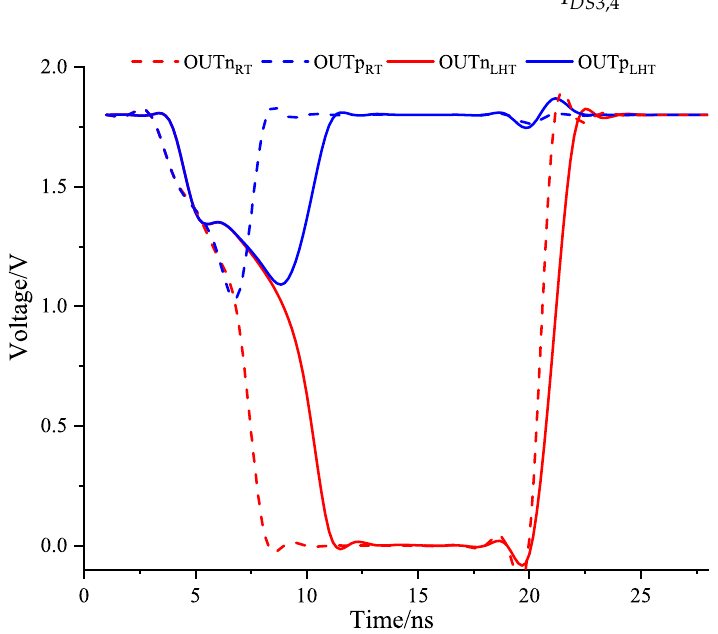
Figure 9. The transient simulation results of the comparator at RT and